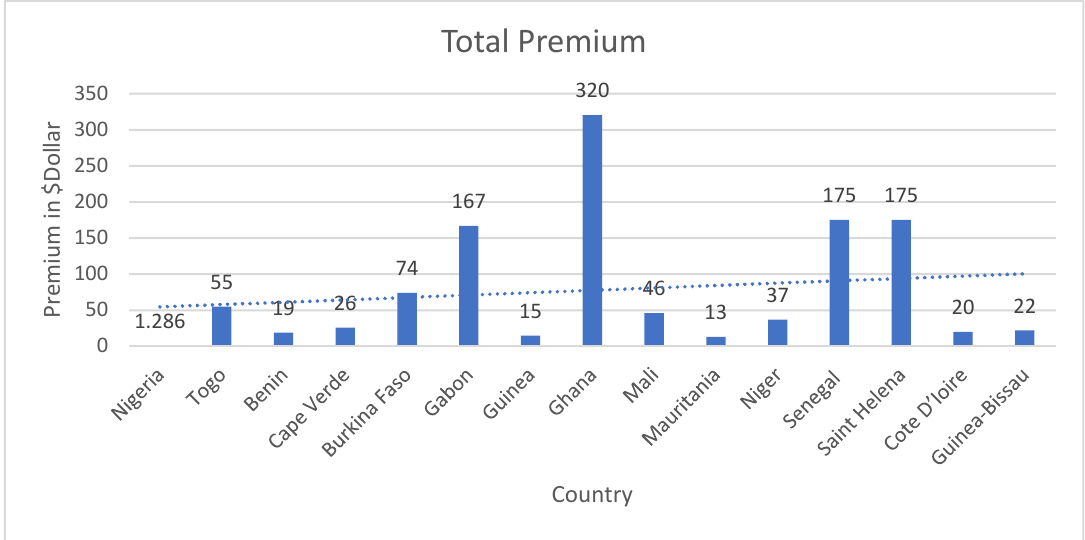
Figure 1. Total insurance premium of West African Countries. Source of data: Re Swiss 2018 (https://www.swissre.com/institute/, accessed on 15 February 2021).